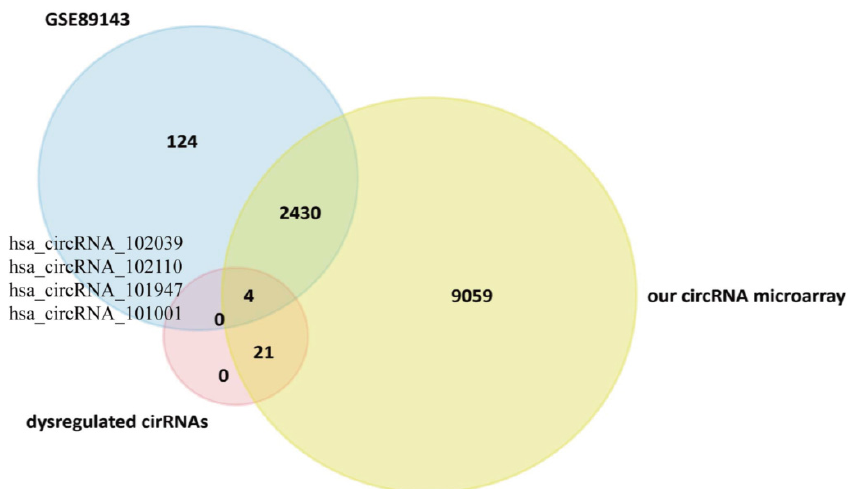
Figure 2. Schematic illustration of the overlapping circRNAs in GC, as identified by GSE89143, our circRNA microarray, and our significantly dysregulated circRNAs.